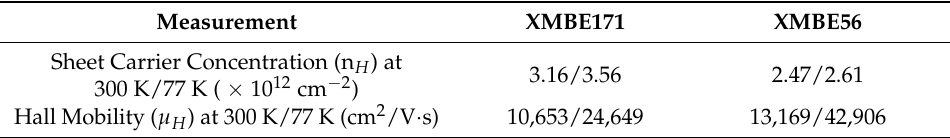
Table 2. XMBE171 and XMBE56 epilayer hall effect measurements data.